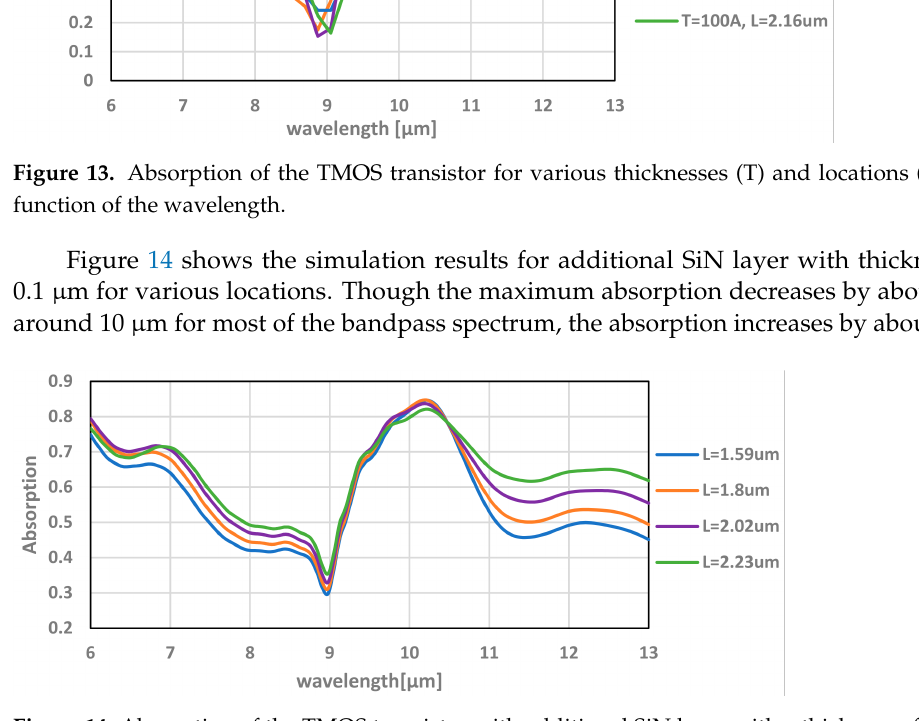
Figure 14. Absorption of the TMOS transistor with additional SiN layer with a thickness of 0.1 µ m for various locations (L) as a function of the